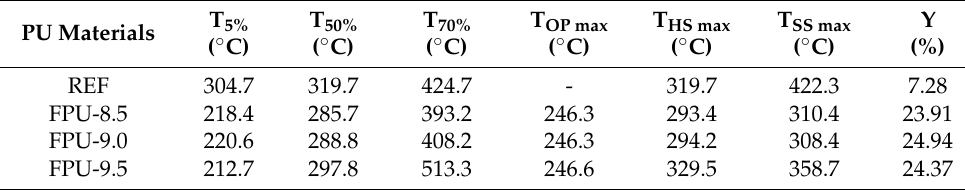
Table 4. TGA and DTG results for PU materials tested under nitrogen